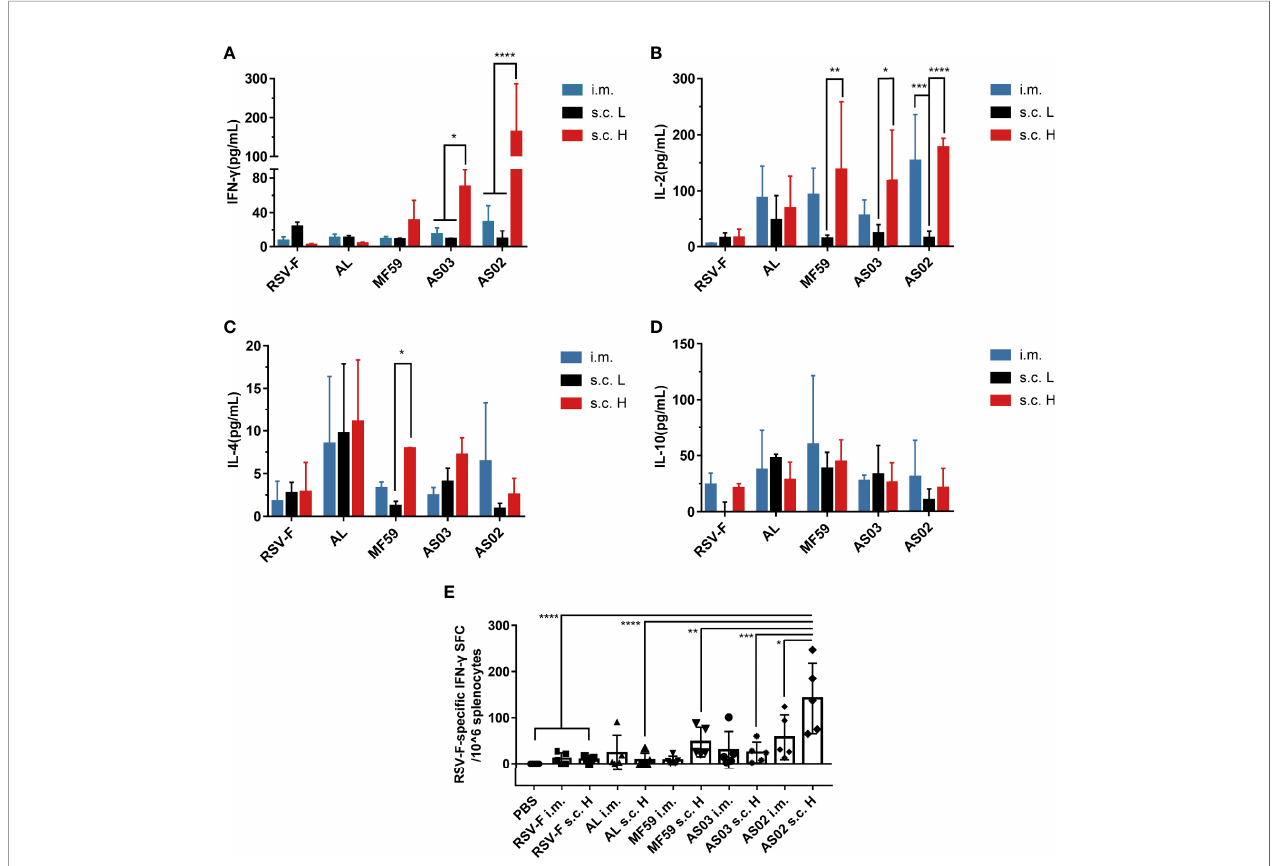
FIGURE 5 | Cytokine levels in immunized mice. Spleen cells were collected from immunized mice at week 2 after boosting and restimulated with RSV-F protein. The secreted cytokines, including IFN- g (A) , IL-2 (B) , IL-4 (C) , and IL-10 (D) , were measured from the supernatants using mouse Th1/Th2 uncoated ELISA kits. In addition, the number of RSV-F-speci fi c IFN- g secreting splenocytes was evaluated by ELISpot (E) . Data were collected from two independent experiments. Means ± SD of fi ve mice per group was shown. *P< 0.05, **P <0.01, ***P< 0.001, ****P<0.0001 (two-way ANOVA with Tukey ’ s multiple comparisons